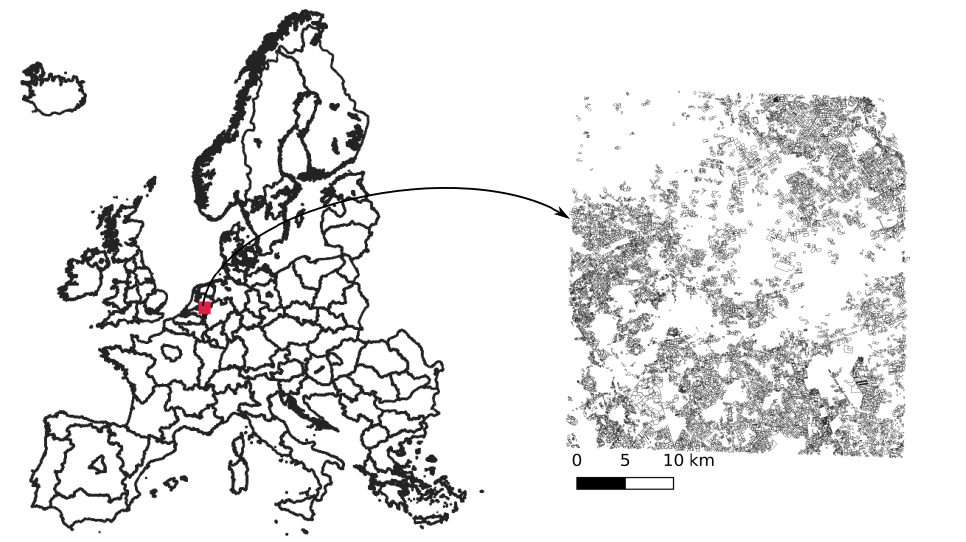
Figure 2. Polygon features (36,644 in total) representing the parcels for a region in the Netherlands (51.50 ◦ N, 5.75 ◦ E) used for spatial